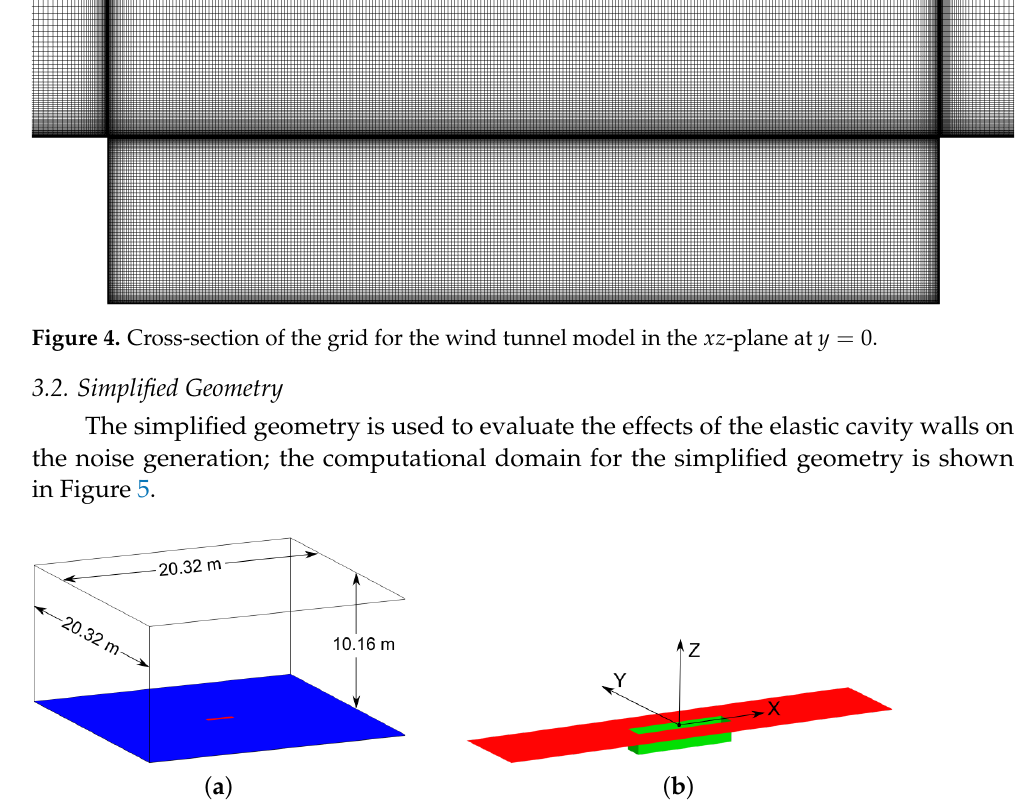
Figure 5. ( a ) Computational domain for the simplified geometry. ( b ) Cavity and top surface. The co- ordinate system is defined with the origin located in the cavity centre on the plane of the top surface. Blue boundary: free-slip. Red and green boundaries: